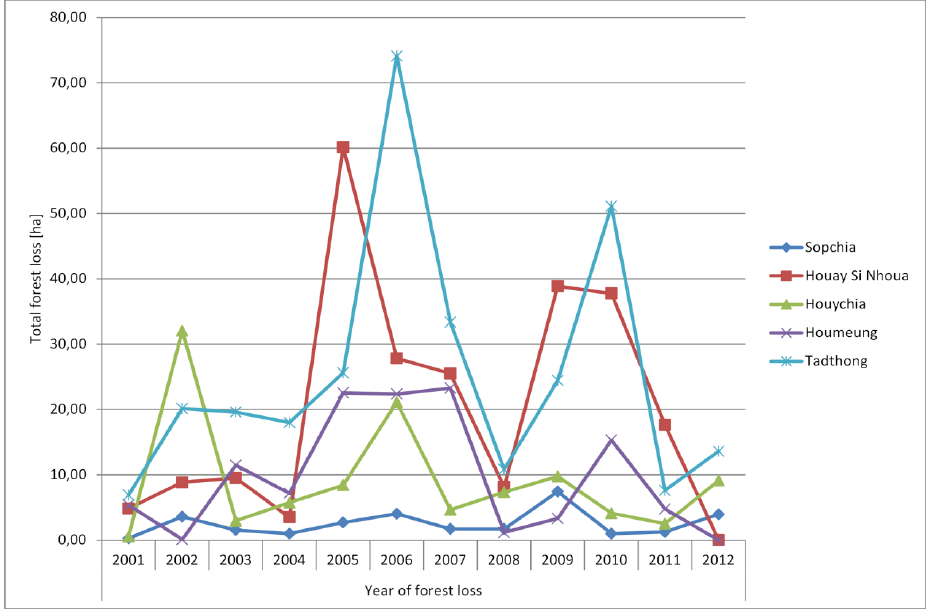
Figure 9. Yearly forest cover loss [ha] in five villages from the case study